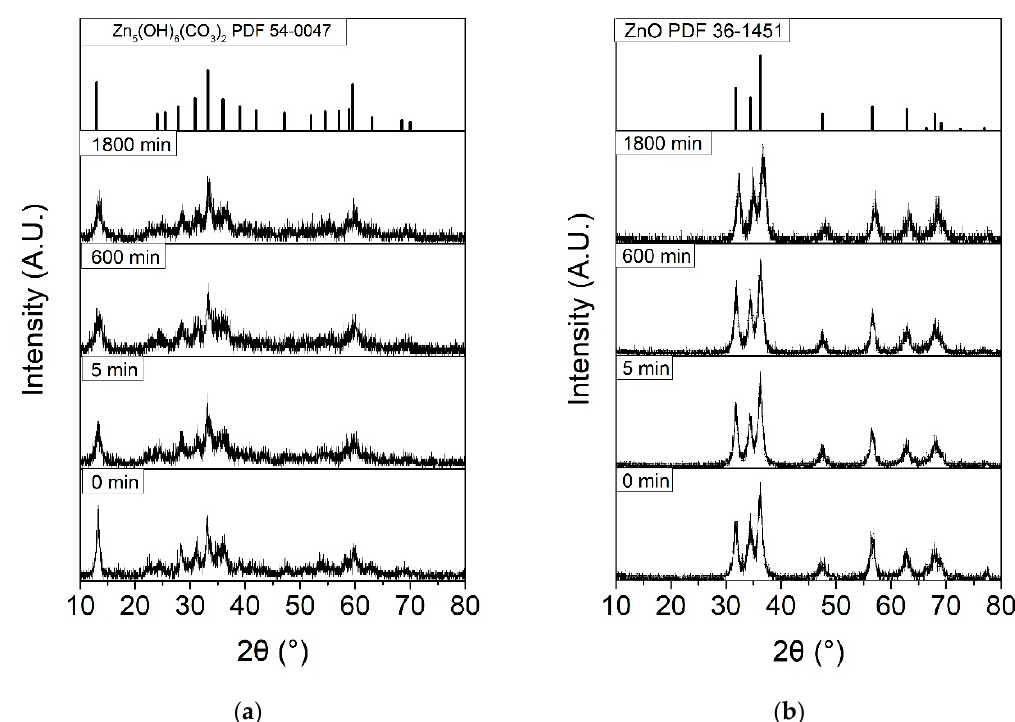
Figure 1. ( a ) XRD patterns of the precursors after different ball milling times; and ( b ) XRD of the products calcined at 300 ◦ °C.